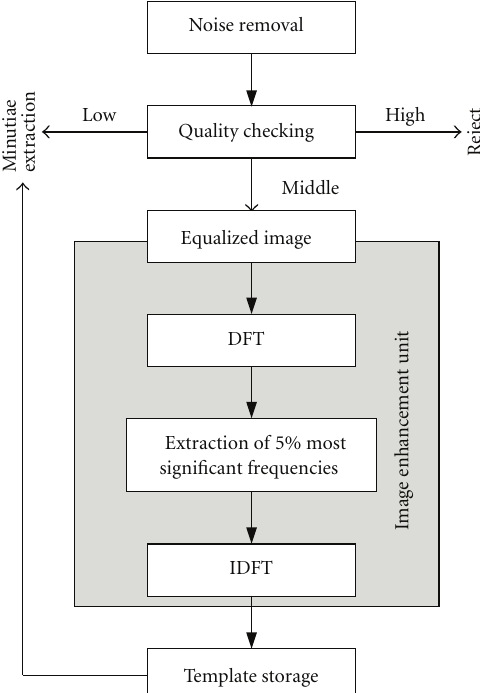
Figure 25: Process of the fingerprint image enhancement.